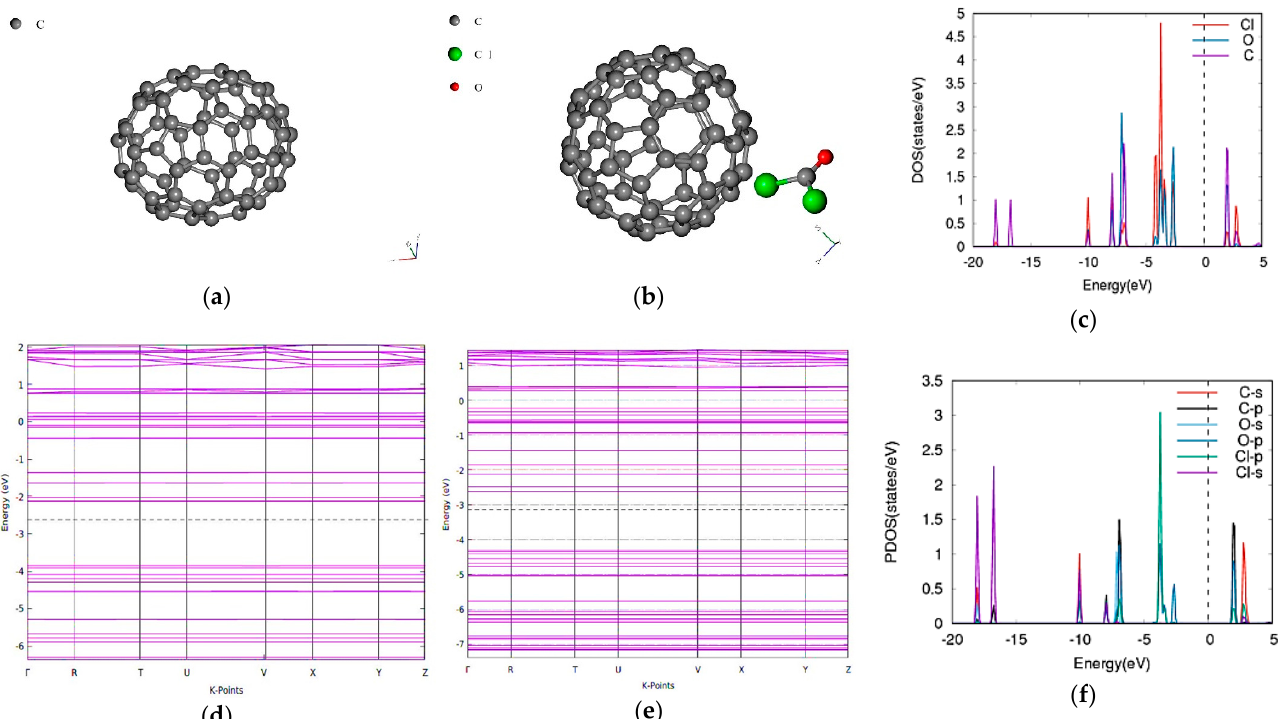
Figure 3. Band structure and density of states for phosgene gas interaction with C70. ( a ) C70, ( b ) phosgene-C70, ( c ) phosgene-C70 DOS, ( d ) C70 band structure Eg = 1.7273eV, ( e ) phosgene-C70 Eg = 1.7033 eV, ( f ) phosgene-C70 PDOS.